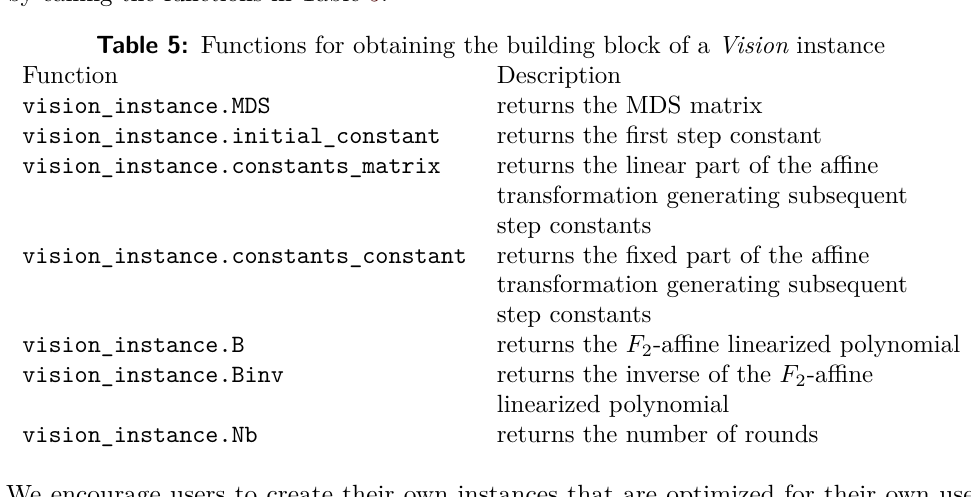
Table 5: Functions for obtaining the building block of a Vision instance